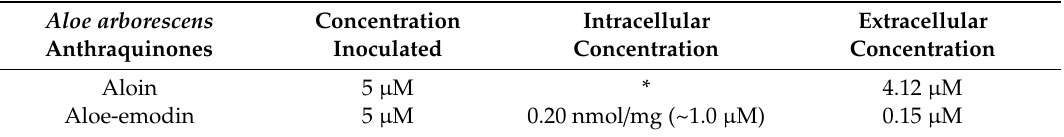
Table 3. The extra- and the intracellular amounts of aloin and aloe-emodin in HT-29 cells in culture. Aloe arborescens Anthraquinones